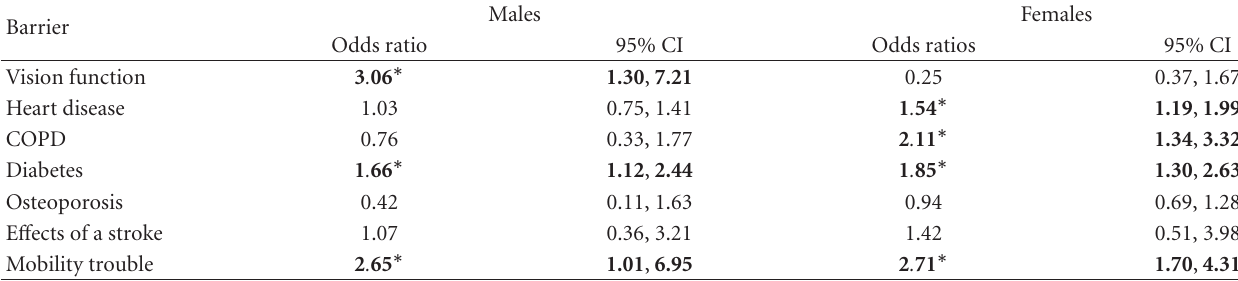
Table 5: Odds of nonparticipation as a function of health